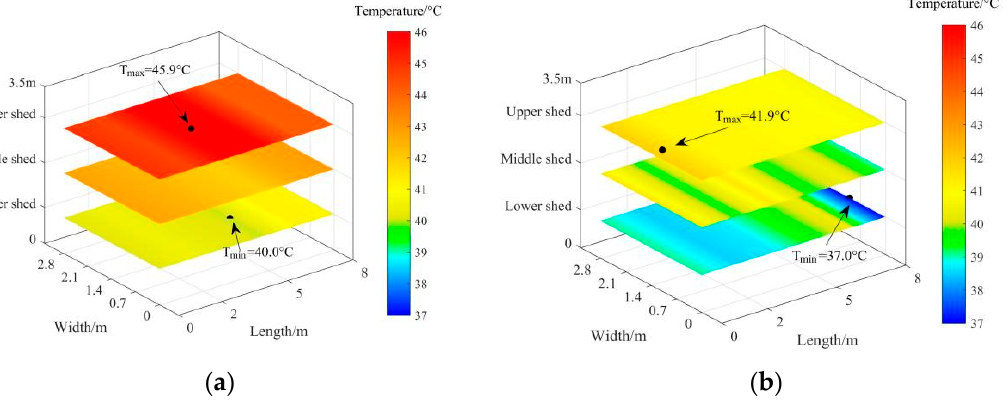
Figure 5. The temperature distribution of ( a ) TCCB and ( b ) HPCB with a curing temperature of 38 ◦ C.